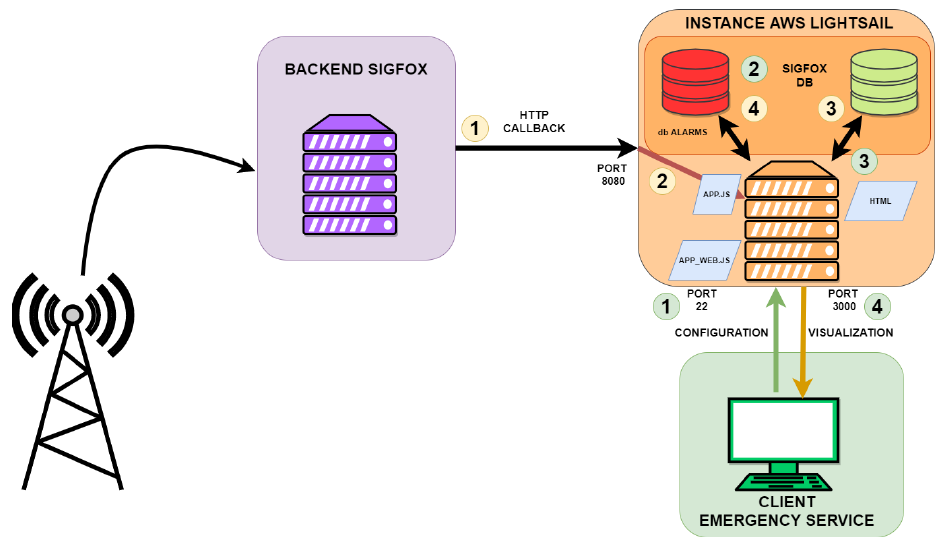
Figure 5. Layer 3: Backend Sigfox and emergency server